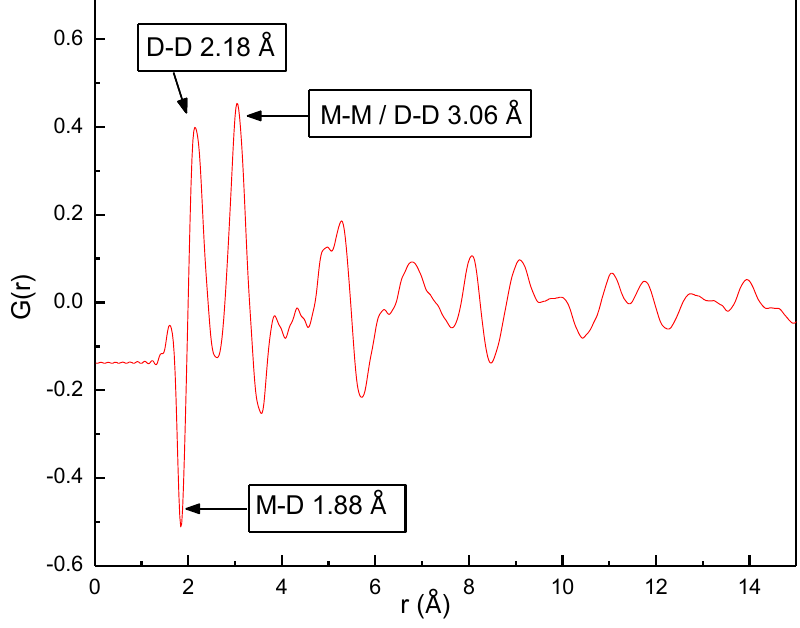
Figure 5. The pair distribution function G( r ) of Ti 0.63 V 0.27 Fe 0.10 D 1.73 from neutron total scattering data.